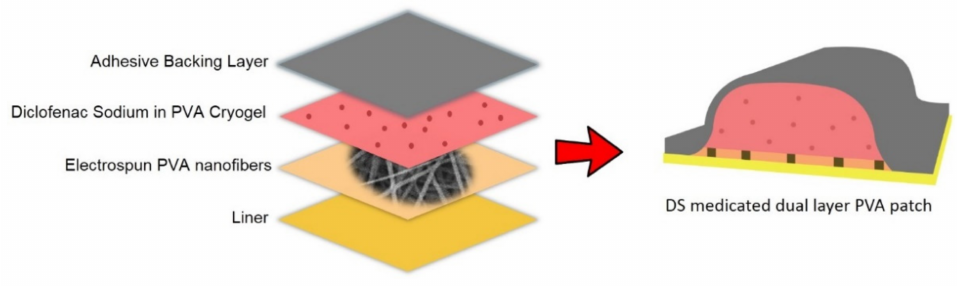
Figure 10. Components of proposed DS-Medicated dual layer PVA patch.